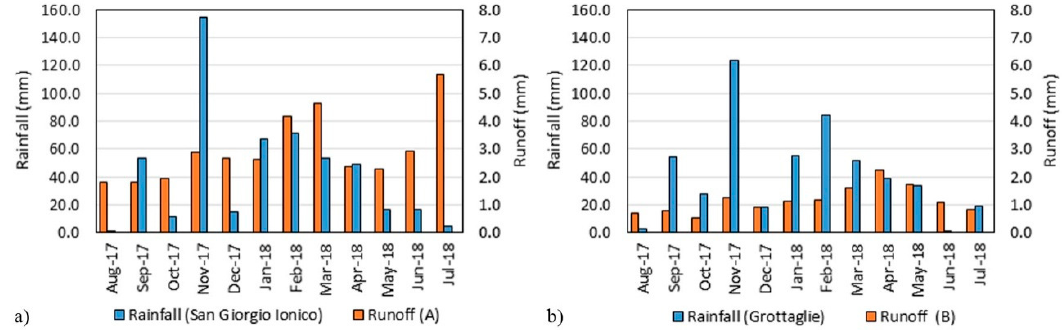
Figure 4. Monthly runoffs measured at gauges A ( a ) and B ( b ), and monthly rainfall measured at the nearest gauges (i.e., San Giorgio Ionico station and Grottaglie station, respectively).